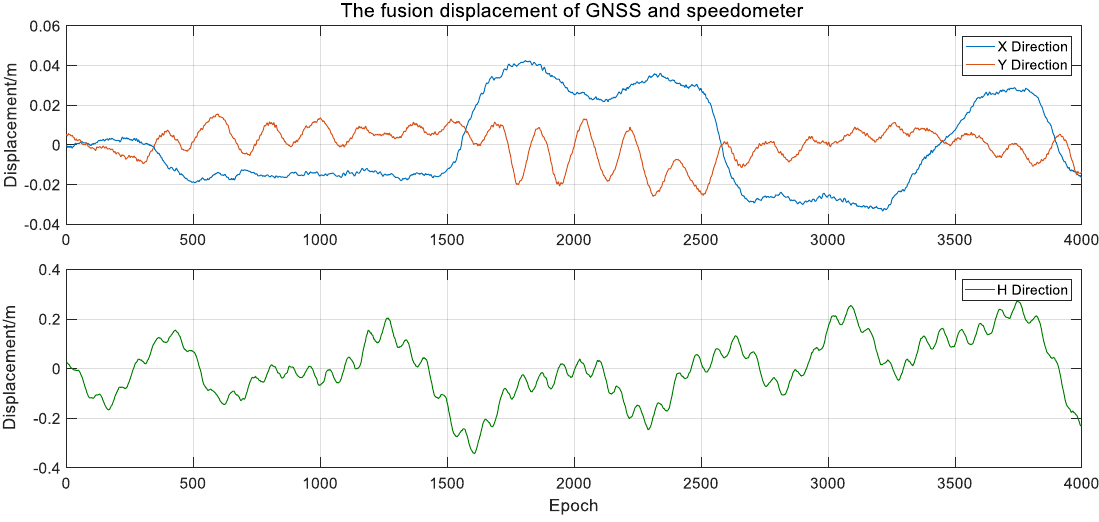
Figure 22. The fusion displacement of GNSS and speedometer.